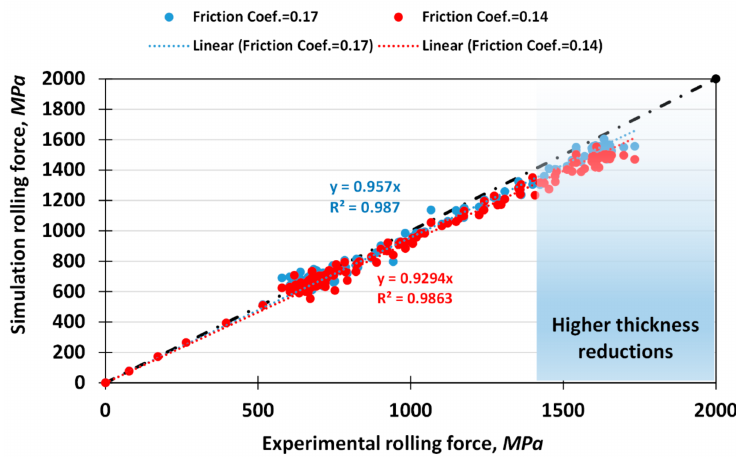
Figure 11. Simulation rolling force vs. experimental rolling force for friction coefficients of 0.14 and 0.17.